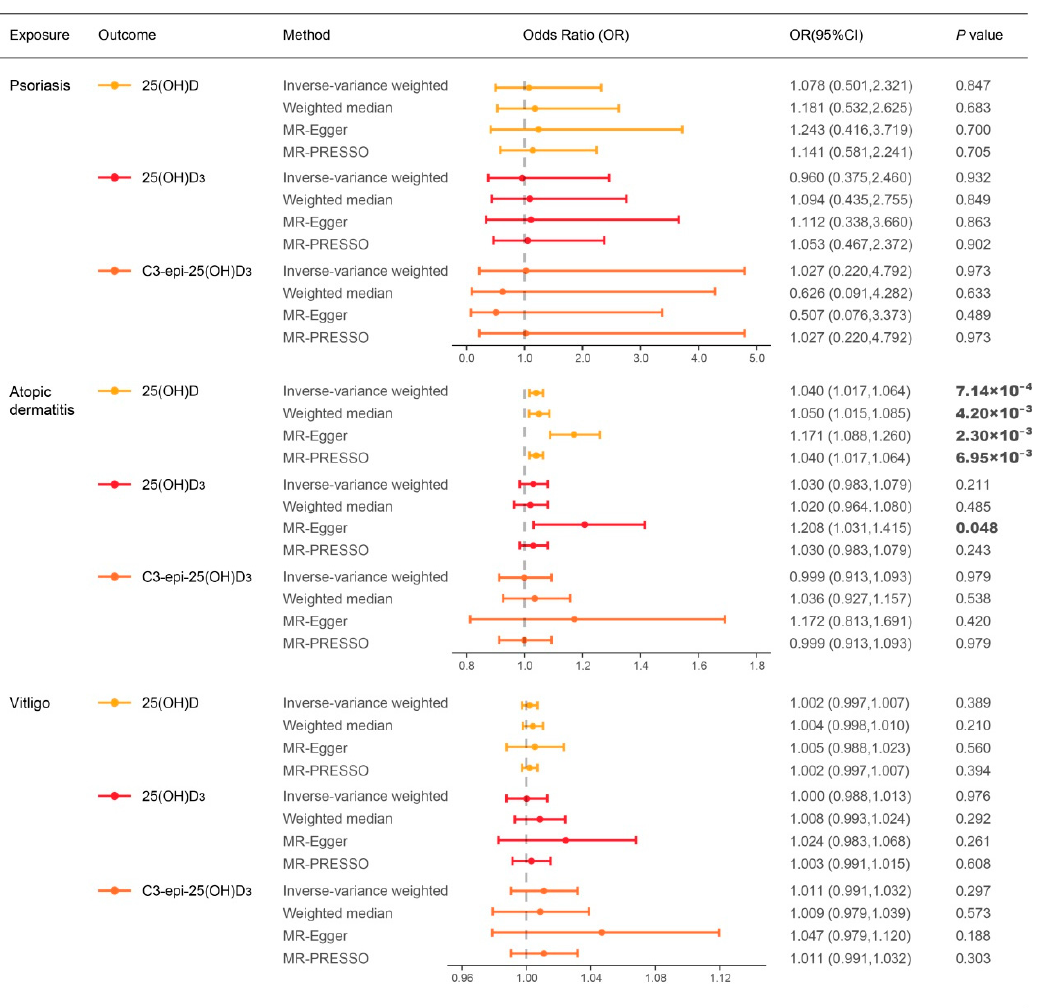
Figure 3. Causal estimates of risk of atopic dermatitis, vitiligo, and psoriasis on vitamin D levels through MR analysis. The significant p values at p < 0.05 are in bold. Abbreviations: 25(OH)D: 25-hydroxyvitamin D; 25(OH)D 3 : 25-hydroxyvitamin D 3 ; C3-epi-25(OH)D 3 ; C3-epimer of 25-hydroxyvitamin D 3 ; MR: Mendelian randomization; MR-PRESSO: Mendelian randomization pleiotropy residual sum and outlier test; OR: odds ratio; CI: confidence interval.